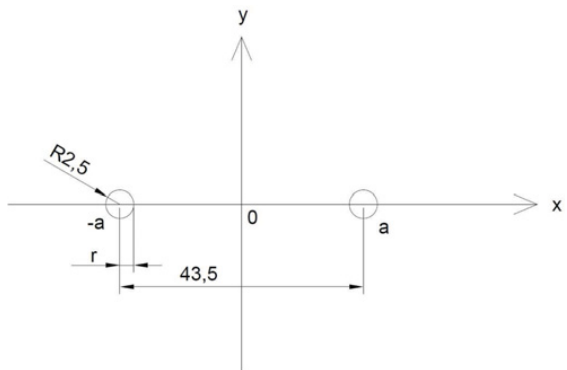
Figure 5. The positively and negatively charged wires of a BN gate belong to two concatenated grids. The schematic shows the geometry of adjacent wires, with dimensions in mil.